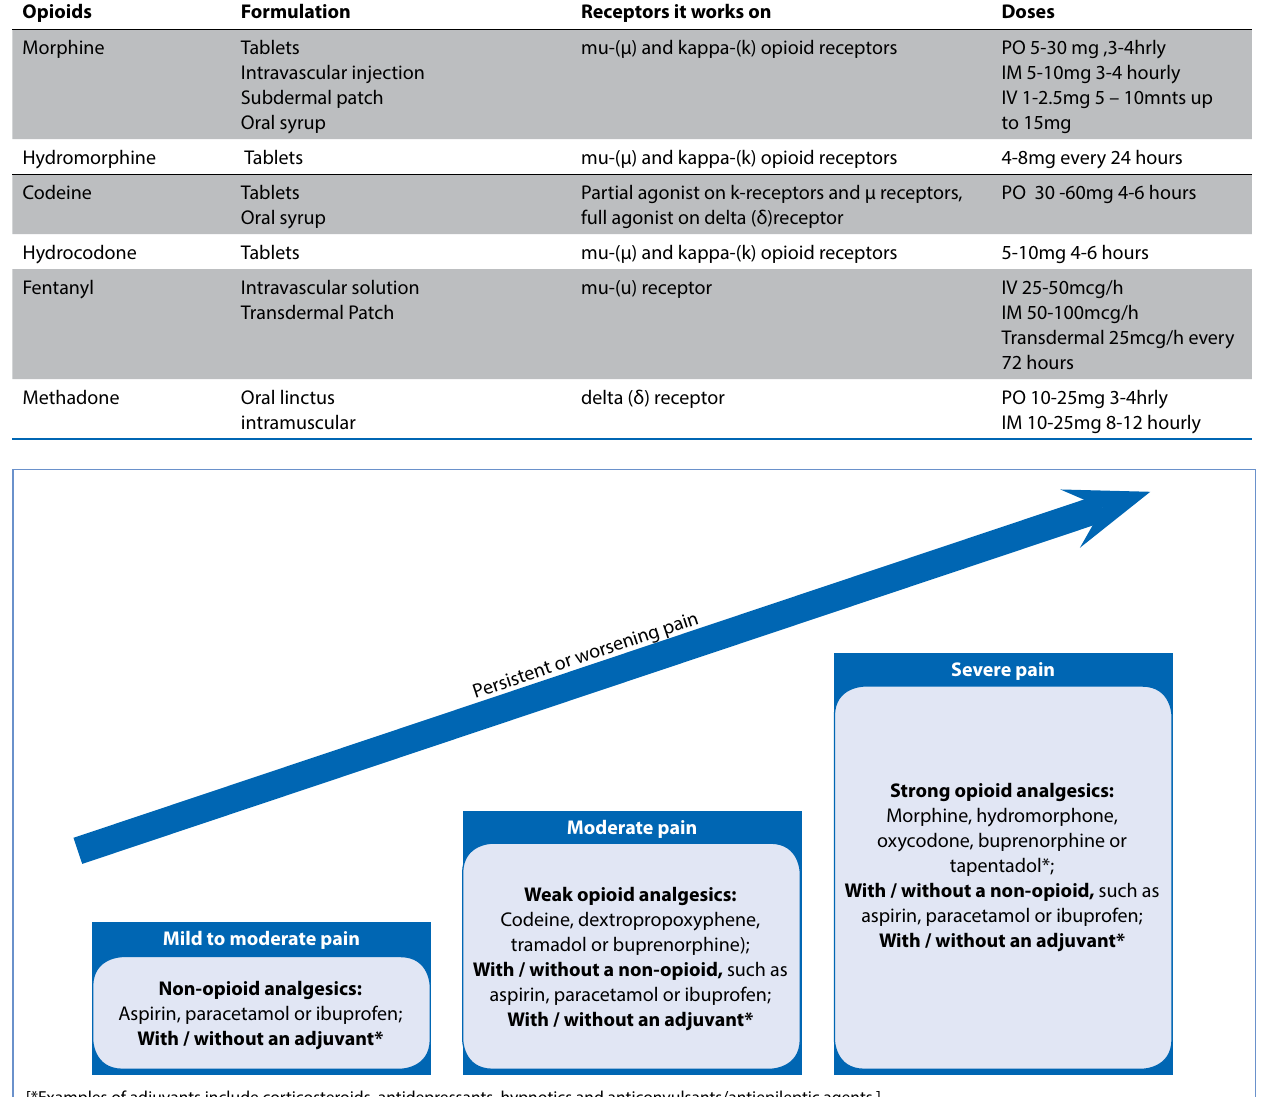
Figure 2: The World Health Organization’s three-step analgesic ladder